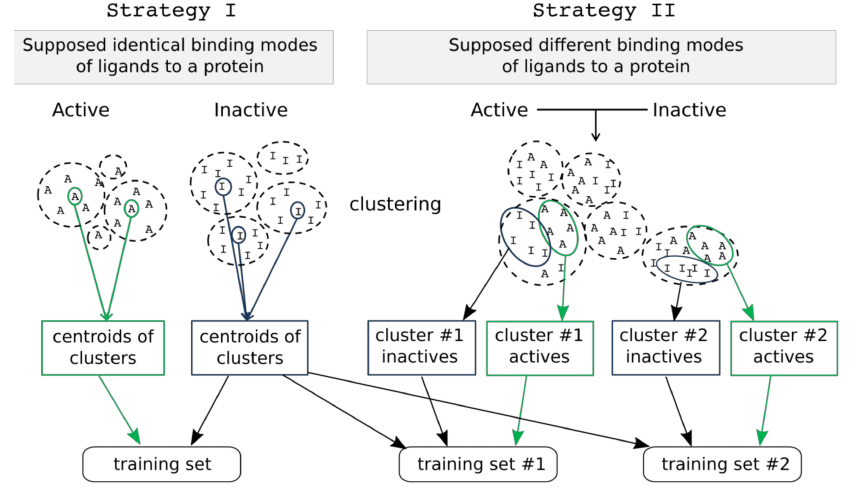
Figure 5. Two strategies of training set compound